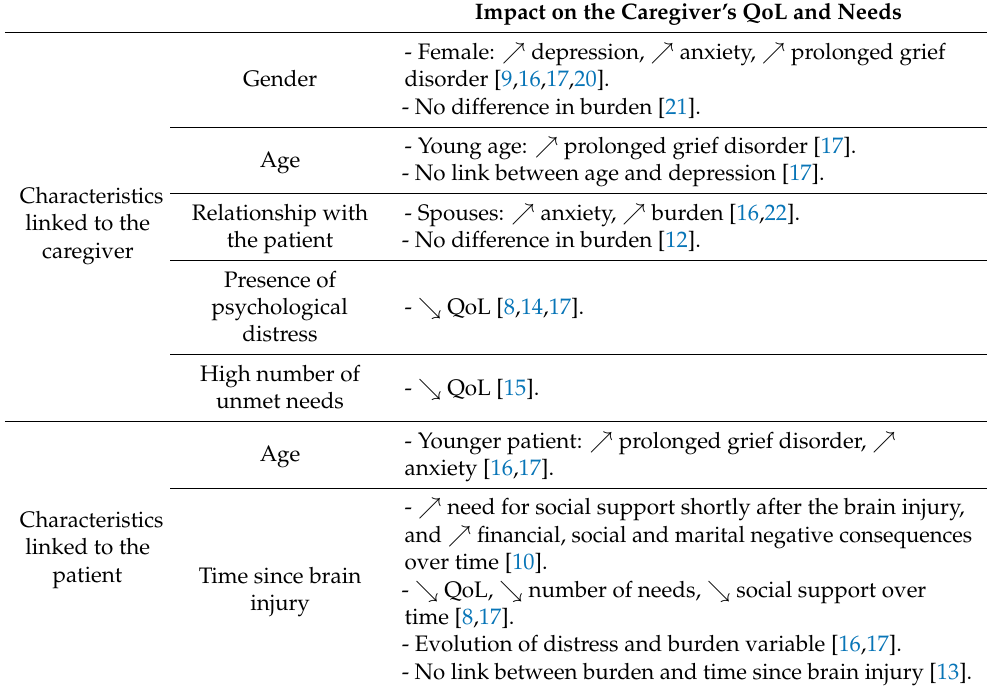
Table 1. Summary of previous findings regarding the impact of caregiver’s and patient’s characteris- tics on the caregiver’s QOL and